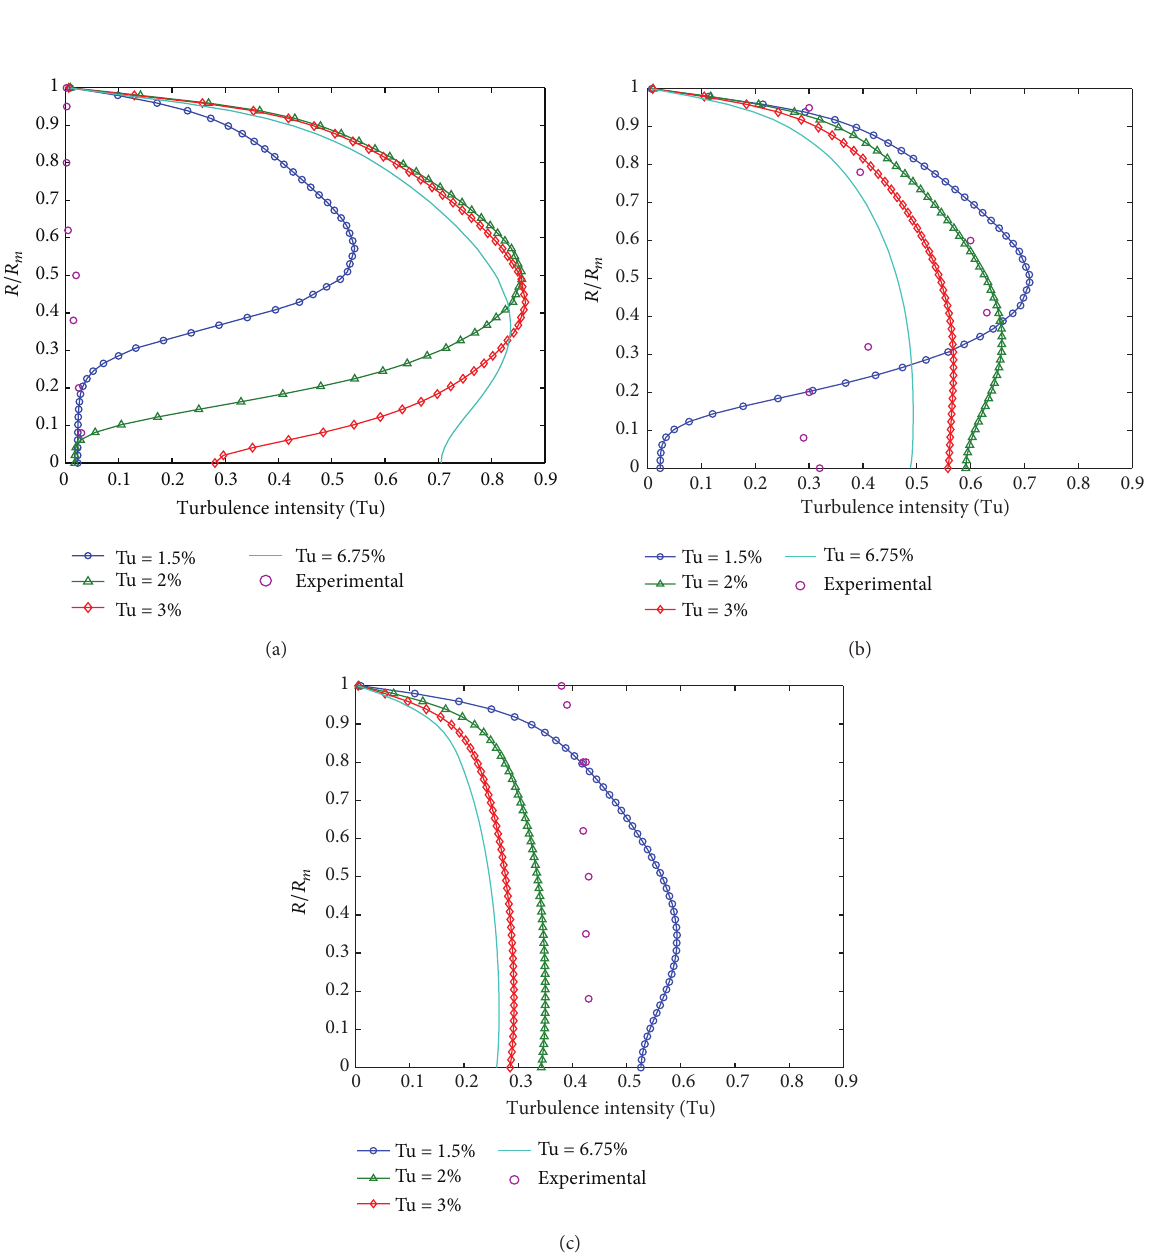
Figure 4: Turbulence intensity profiles at three axial positions: (a) 𝑧 = 2.5 cm, (b) 𝑧 = 4 cm, and (c) 𝑧 = 6 cm of the idealized model for different inlet Tu values. The experimental data from Ahmed and Giddens [23] is shown for